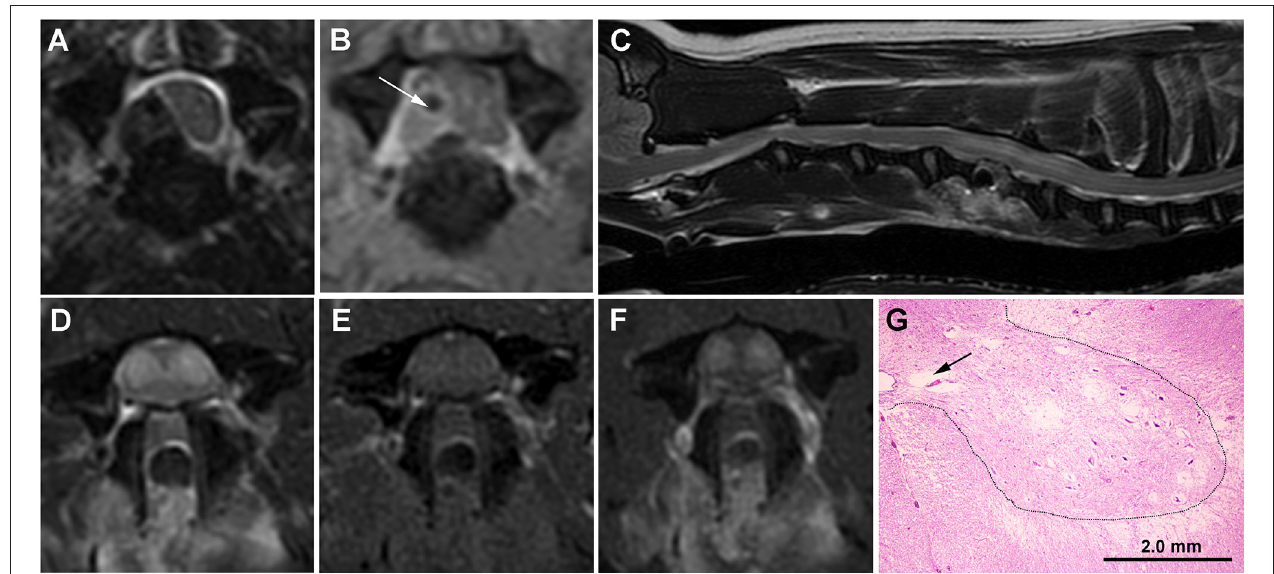
FIGURE 2 | Serial MRI and neuropathology of Case 2. (A) Transverse T2W image with hypointense extradural lesion at C5-C6 disc space, lateralized to the right aspect of the vertebral canal, and causing marked compression and displacement of the spinal cord. The lesion is of mixed signal intensity on transverse TIW post-contrast images (B) suggesting the presence of extradural hemorrhage admixed with hypointense extruded disc (white arrow). (C) Sagittal T2W image obtained 7 days after surgery demonstrating the C5-C6 ventral slot defect and a tubular hyperintense intramedullary lesion extending from the cranial aspect of C5 to the cranial aspect of C7. On transverse images, the SEM-like phenotype appears as bilaterally symmetric T2W hyperintense (D) gray matter lesions that are mildly T1W hyperintense (E) and contrast-enhancing (F) . Despite resolution of the previous extradural compression, the spinal cord throughout the lesion region is swollen with attenuation of the subarachnoid space. (G) Histology of the C6 spinal cord demonstrating various stages of cavitations (black arrow) and gray matter necrosis, with neurons in the lateral portions of laminae VII and IX displaying acidophilic necrosis characterized by angular and hypereosinophilic cytoplasm and nuclear pyknosis. At the junction of the intermediate and ventral gray horns (dashed line) with spinal cord white matter, there is also white matter vacuolization. H&E